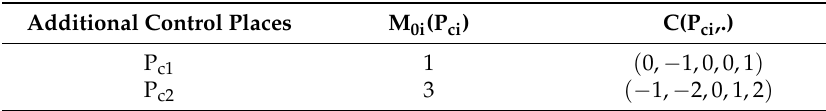
Table 8. PN controllers of Example 2.